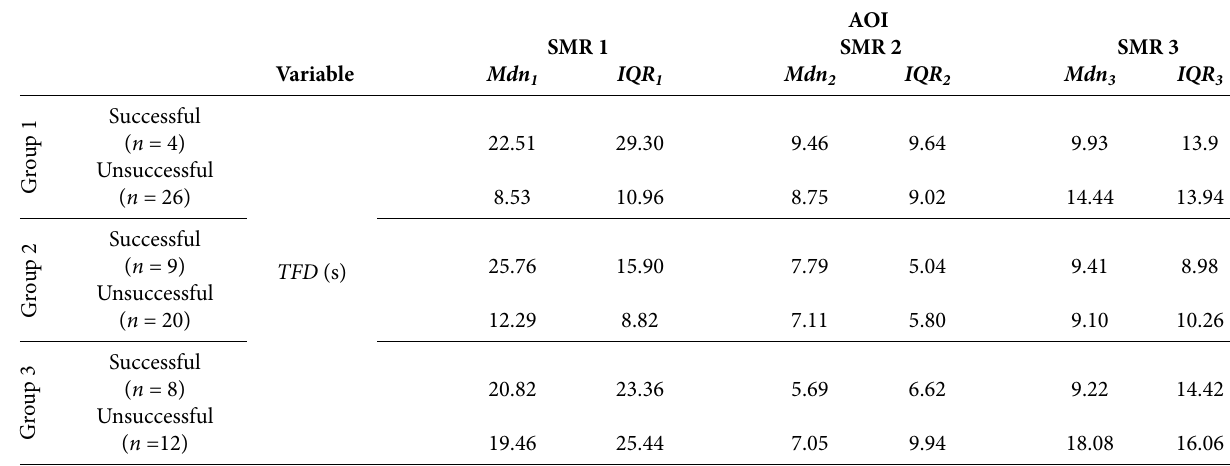
Table 5. Median (Mdn) and interquartile range (IQR) of interest for successful and unsuccessful students of three age groups in Task 3 (freezing of water). The correct SMR is SMR